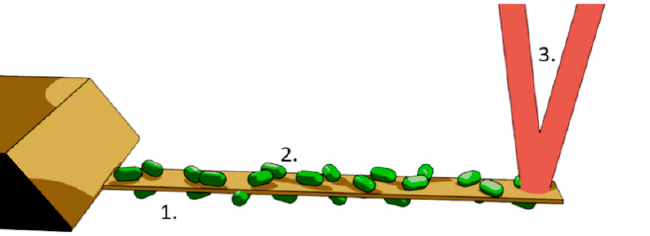
Figure 2. Setup to detect nanomotion of living organisms with an AFM cantilever. 1. AFM cantile- ver, 2. bacteria attached on both sides of the lever, 3. laser beam. Table 3. Antimicrobial susceptibility testing applications of the AFM cantilever method for pathogenic microorganisms. Microorganisms